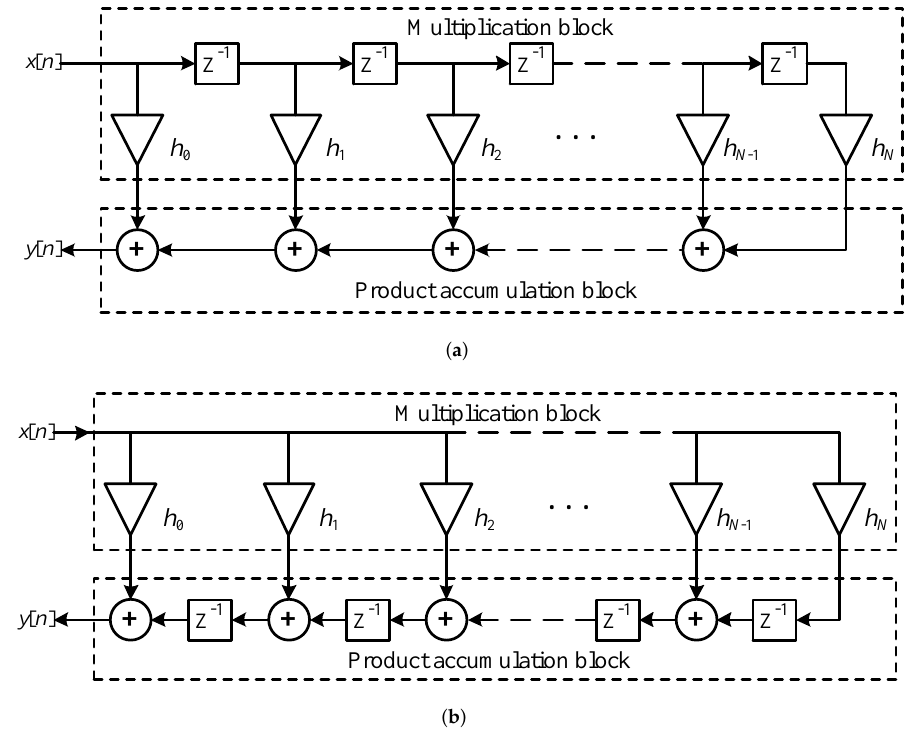
Figure 1. FIR filter structures: ( a ) direct form structure and ( b ) transposed direct form